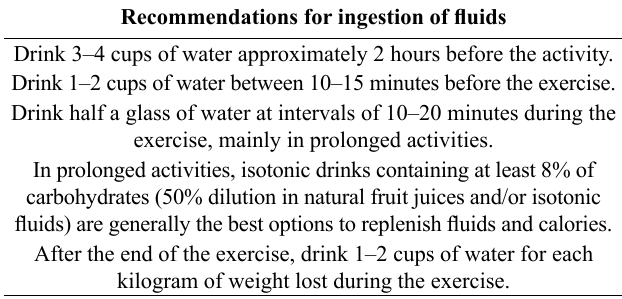
Table 2. Recommendations regarding fluid ingestion before, during, and after physical activities for patients with